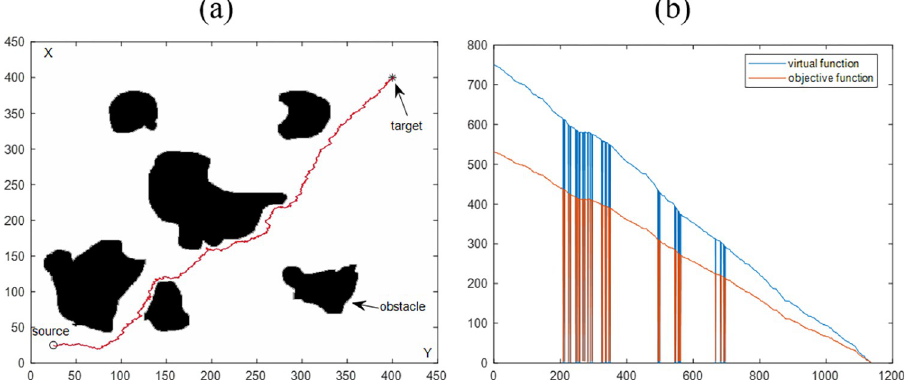
Fig 8. Path planning results are synthesized by the VBAS algorithm to avoid multiple irregular obstacles. (a) Motion results in a 2D plane. (b) Relationship between function and number of iterations.